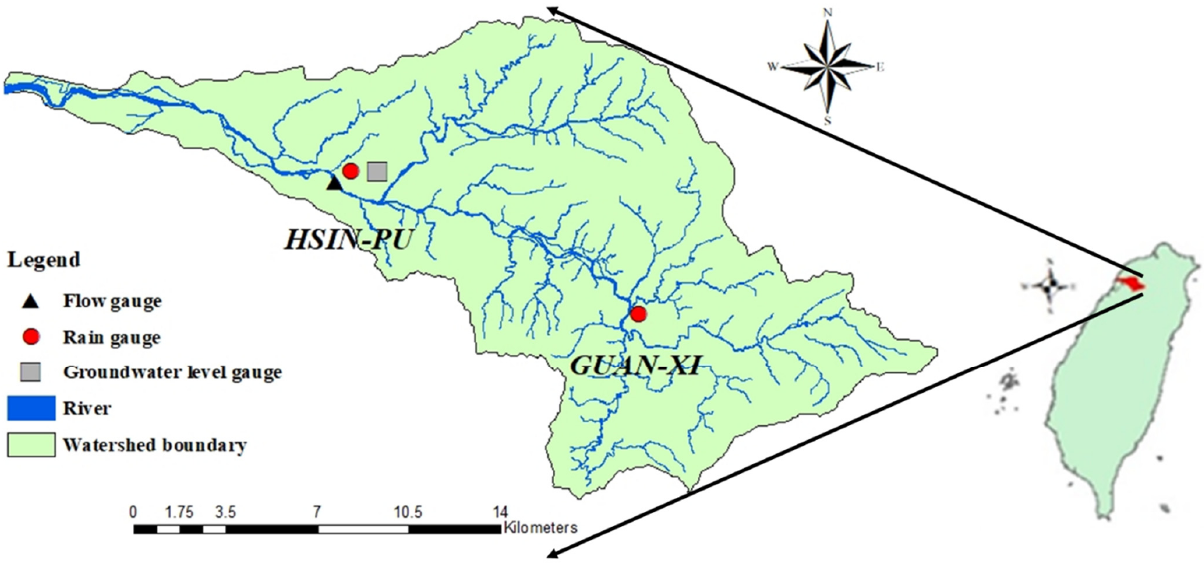
Figure 1. Fèngsh ā n River Basin location map. Figure 1. F è ngsh¯an River Basin location